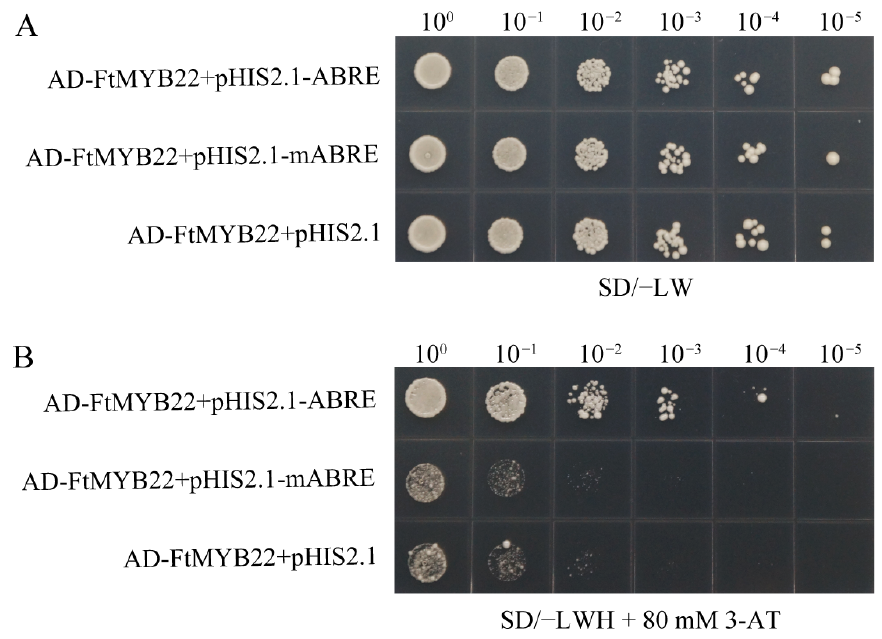
Figure 14. Yeast single hybridization of FtMYB22 with ABRE binding elements. ( A ) Growth phenotype of yeasts on SD/ − LW (SD/ − Trp/ − Leu) medium. ( B ) Growth phenotype of yeast on SD/ − LWH (SD/ − Trp/ − Leu/ − His) + 3-AT medium. Yeast cells were co-transformed with the plasmids as indicated. The yeast cells co-transformed plasmids were serially diluted by 10, 100, 1000, 10,000 and 100,000 folds.